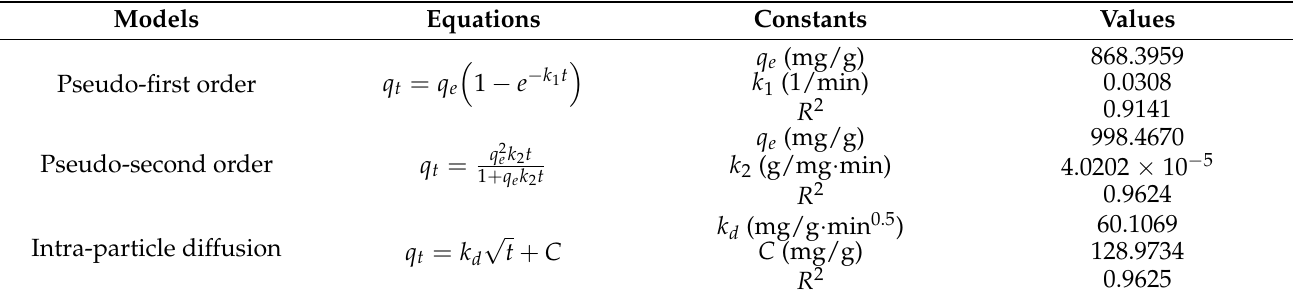
Table 5. Adsorption kinetic modelling constants of CV dye adsorption onto HKUST-1.